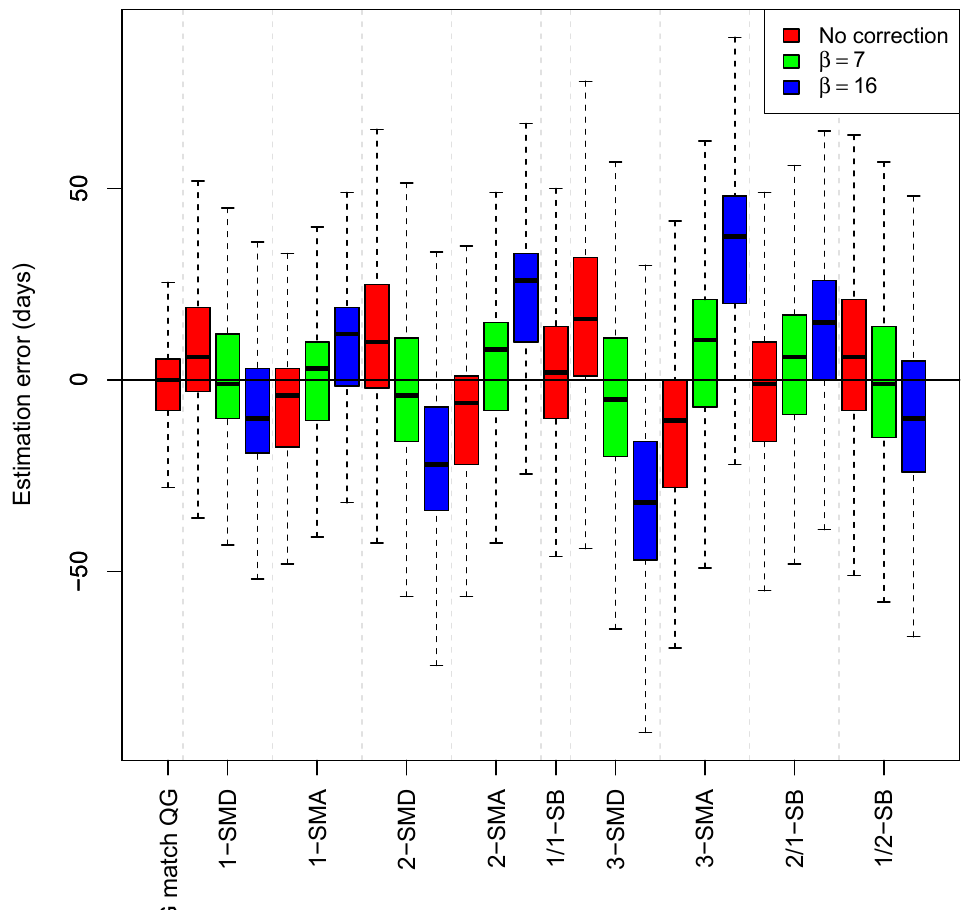
Figure 3. Timeframes (median values for the time of a QG ( t E-QG ) and interquartile ranges) for QGs in simple phylogenetic models. β = time correction by a single substitution; 1-SMD = RG is a 1-step mutational derivative from QG; 1-SMA = RG is a 1-step mutational ancestor from QG; 1/1-SB = RG and QG are in sister branches of 1-step mutational length each; 2-SMD = RG is a 2-step mutational derivative from QG; 2-SMA = RG is a 2-step mutational ancestor from QG; 3-SMD = RG is a 3-step mutational derivative from QG; 3-SMA = RG is a 3-step mutational ancestor from QG; 2/1-SB = RG and QG are in sister branches, the length of the RG branch is 2 substitutions and the length of QG is 1 substitution; 1/2-SB = RG and QG are in sister branches, the length of the RG branch is 1 substitution and the length of QG is 2 substitutions.